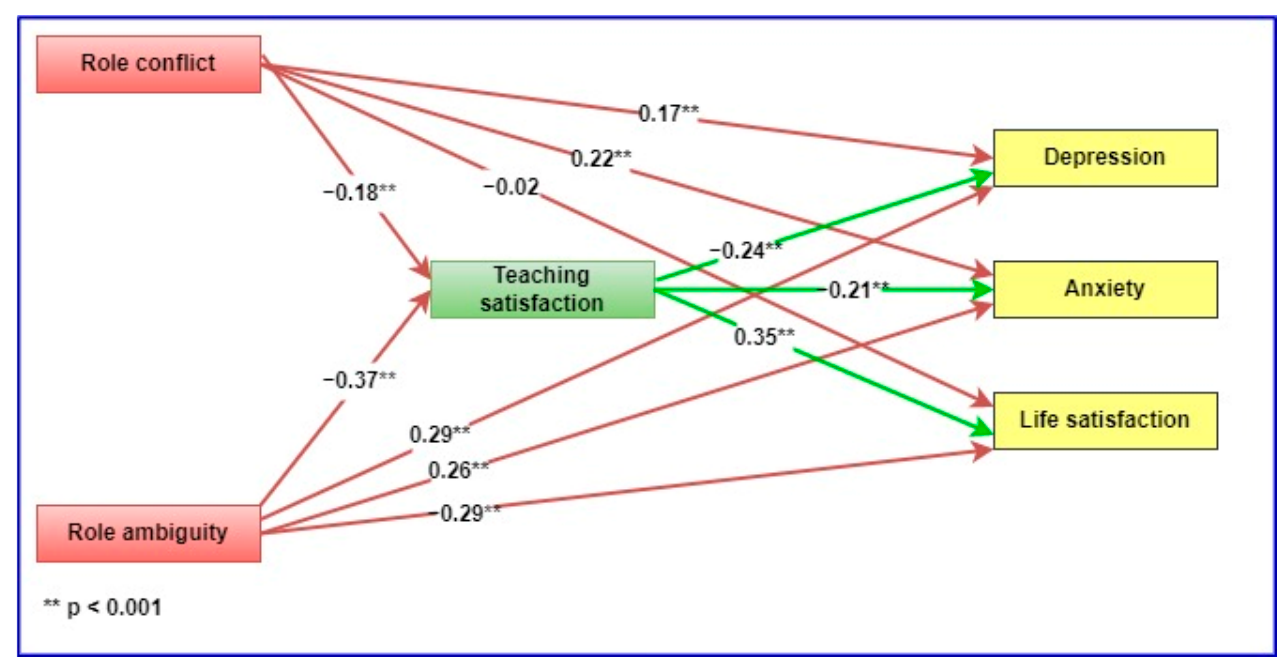
Figure 1. Path-analysis model of the relationship between role stress, teaching satisfaction and psychological well-being.